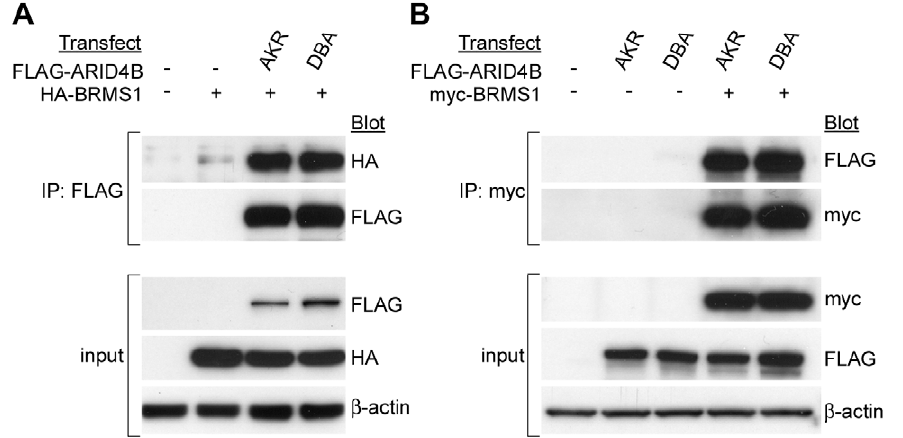
Figure 6. ARID4B binds BRMS1. HA-BRMS1 was coprecipitated with FLAG-ARID4B (A) and FLAG-ARID4B was coprecipitated with myc-BRMS1 (B). No difference in binding to BRMS1 was observed between the AKR and DBA alleles of